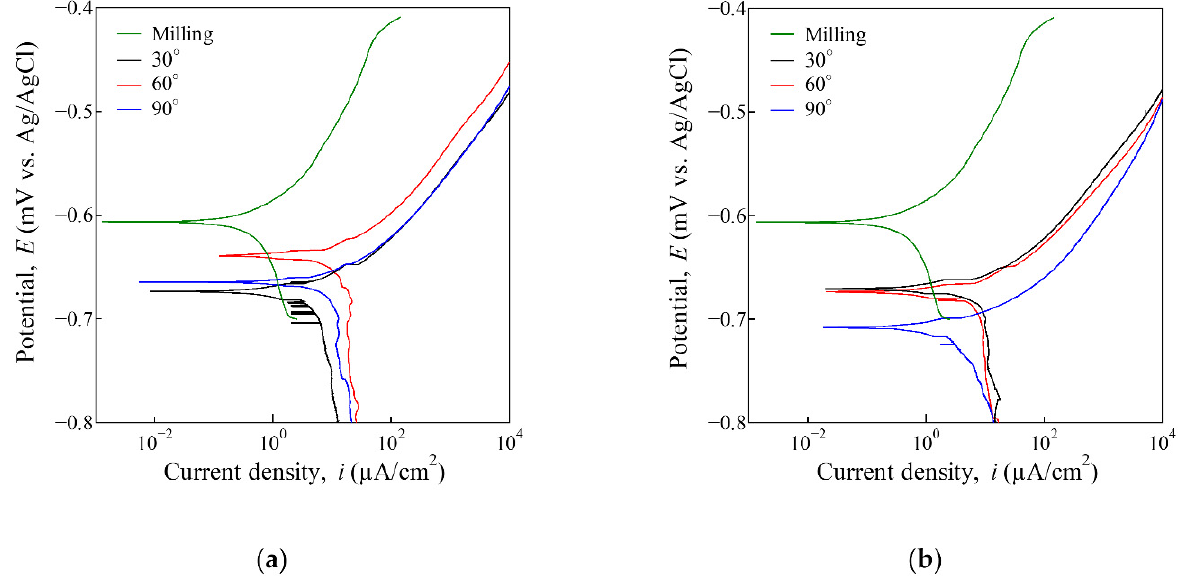
Figure 9. Fracture surface of the painted steel after the adhesion test (Blasting angle 90 ° ): ( a ) MST, ( b ) MAL.